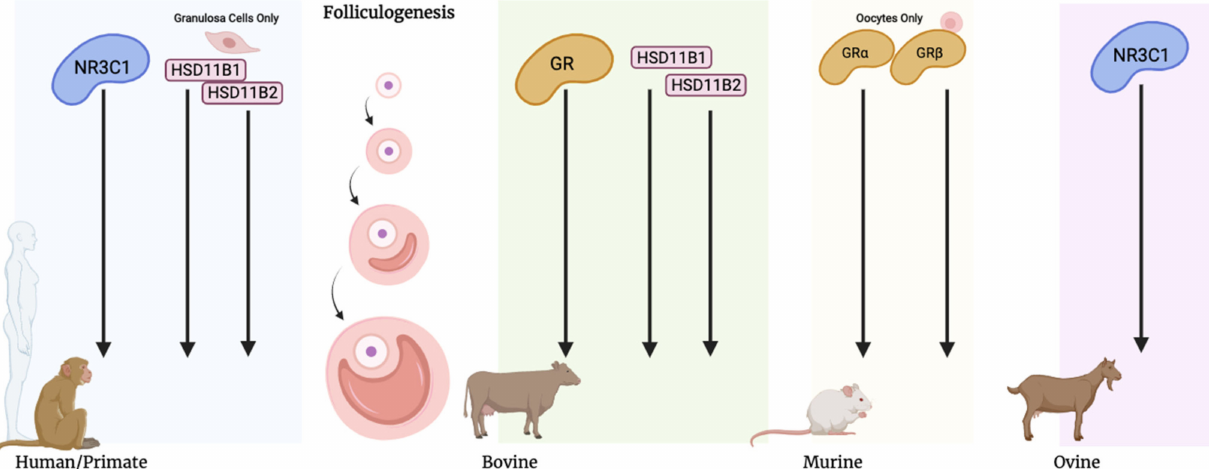
Figure 4. Localization of stress signaling components within ovarian follicles of several mammalian species. Nuclear glucocorticoid receptor NR3C1 has been detected throughout folliculogenesis in human, primate, and ovine models. GRs are also present throughout folliculogenesis in bovine and murine models, though only reported in oocytes in the latter. Enzymes HSD11B1 and HSD11B2 have been detected in human granulosa cells and bovine follicles throughout